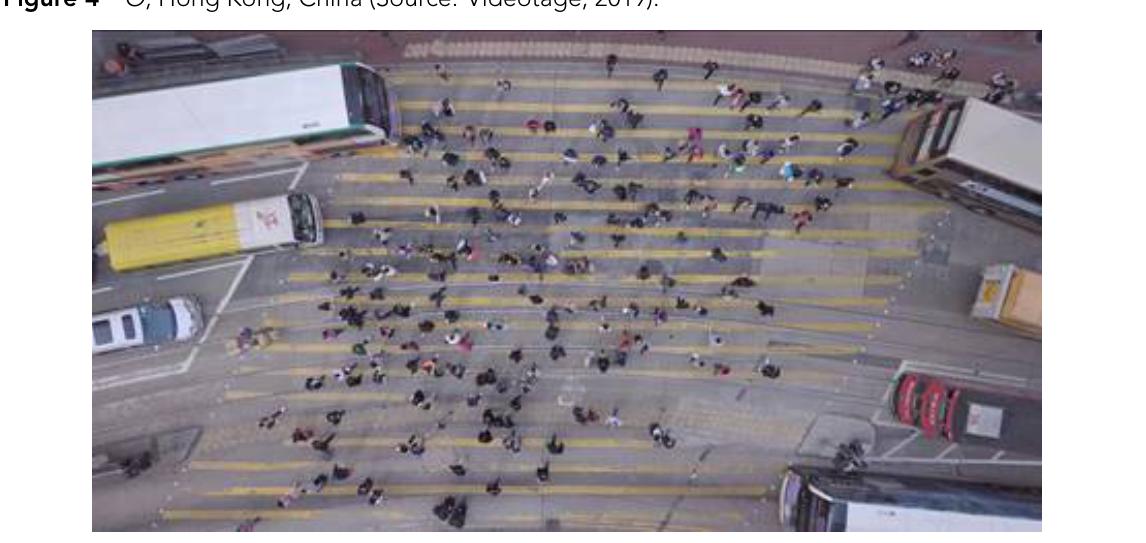
Figure 4 O , Hong Kong, China (Source: Videotage,